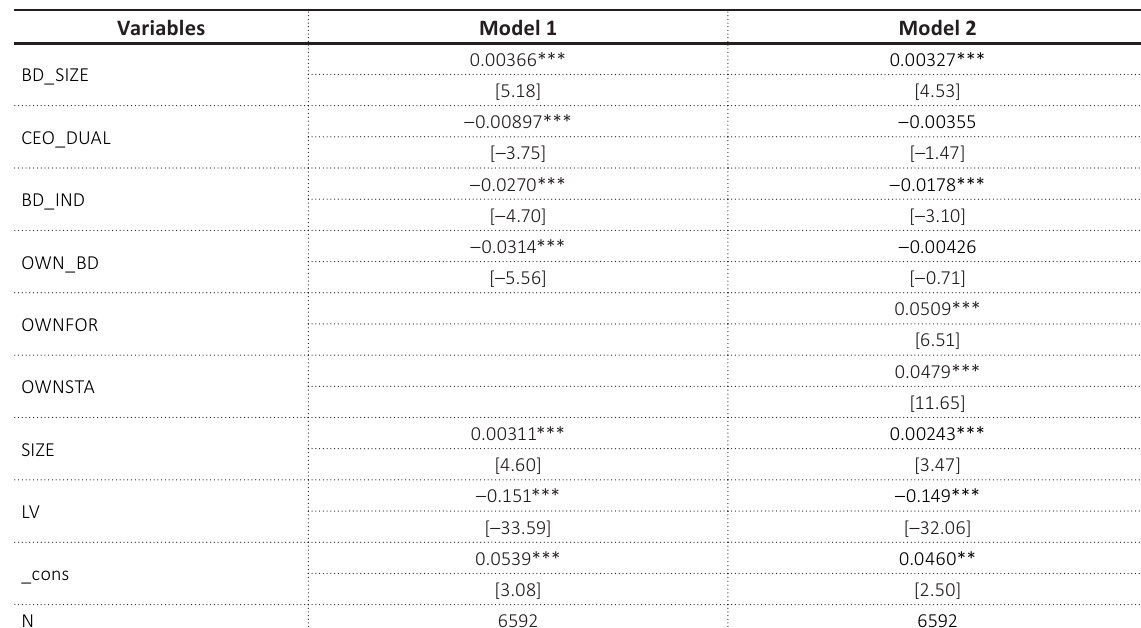
Table 4. Regression